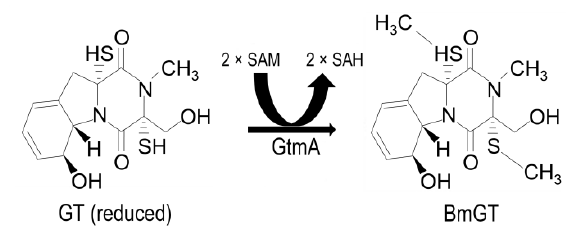
FIGURE 1: Conversion of reduced GT to BmGT is mediated by GtmA protein. Reduced GT undergoes bis -thiomethylation via the action of GtmA protein and requires two molecules of SAM for the reaction to reach completion [14]. Consequently two mole- cules of SAH are produced that re-enter the methyl-methionine cycle [17].